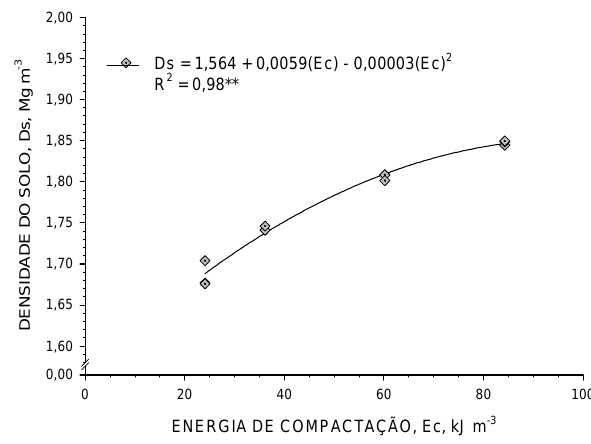
Figura 6. Densidade do solo, considerando a energia de compactação utilizada no ensaio Proctor, para um Argissolo Vermelho-Amarelo arênico com umidade gravimétrica de 0,05 kg kg -1 (** modelo ajustado é significativo a p ≤≤≤≤≤ 0,01 pelo teste F).